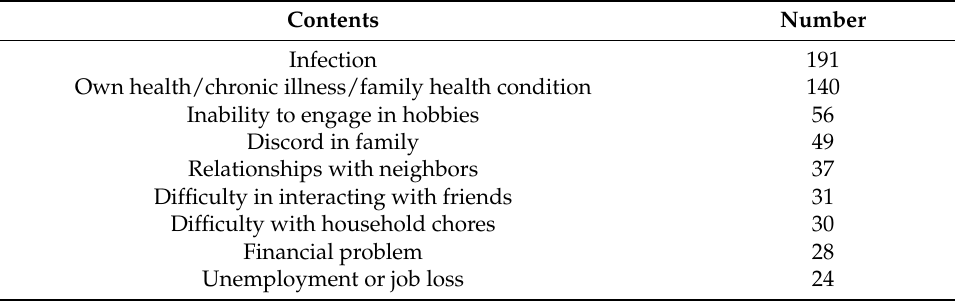
Table 4. “Stressful” contents (multiple responses).